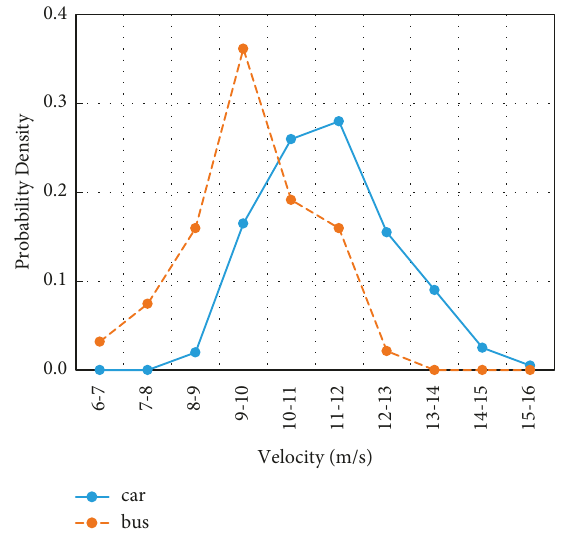
Figure 9: The distribution of car and bus desired velocity